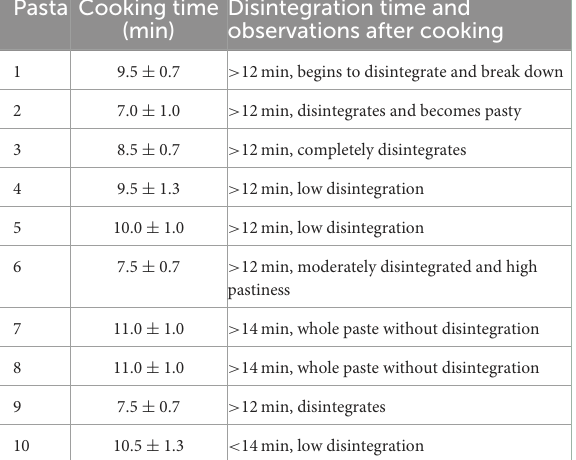
TABLE 6 Cooking time determined and visual observations after cooking in hyper-protein quinoa-based pasta. Pasta Cooking time